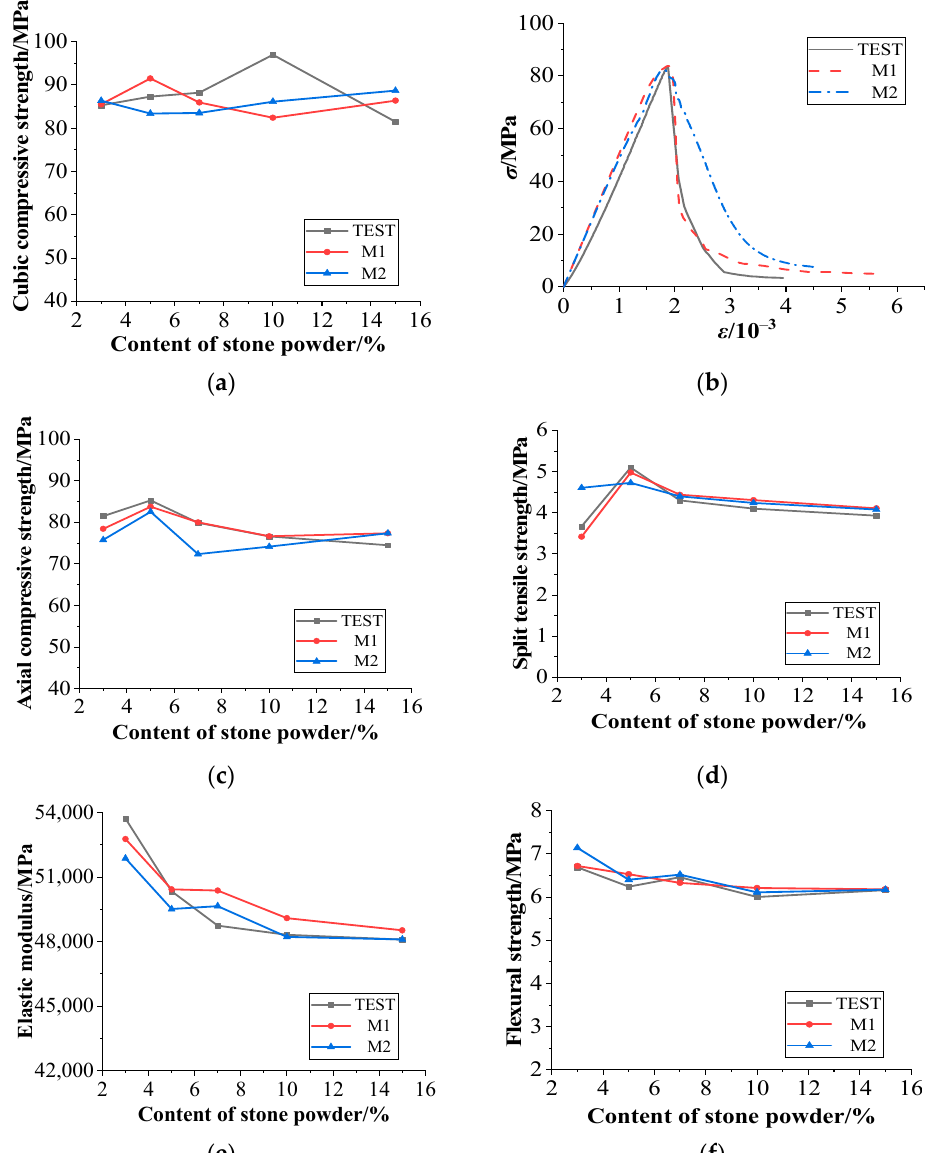
Figure 15. Comparison of experiment and simulation: ( a ) cubic compressive strength, ( b ) stress– strain curves of concrete with 5% stone powder content, ( c ) axial compressive strength, ( d ) split tensile strength, ( e ) elastic modulus, and ( f ) flexural strength.